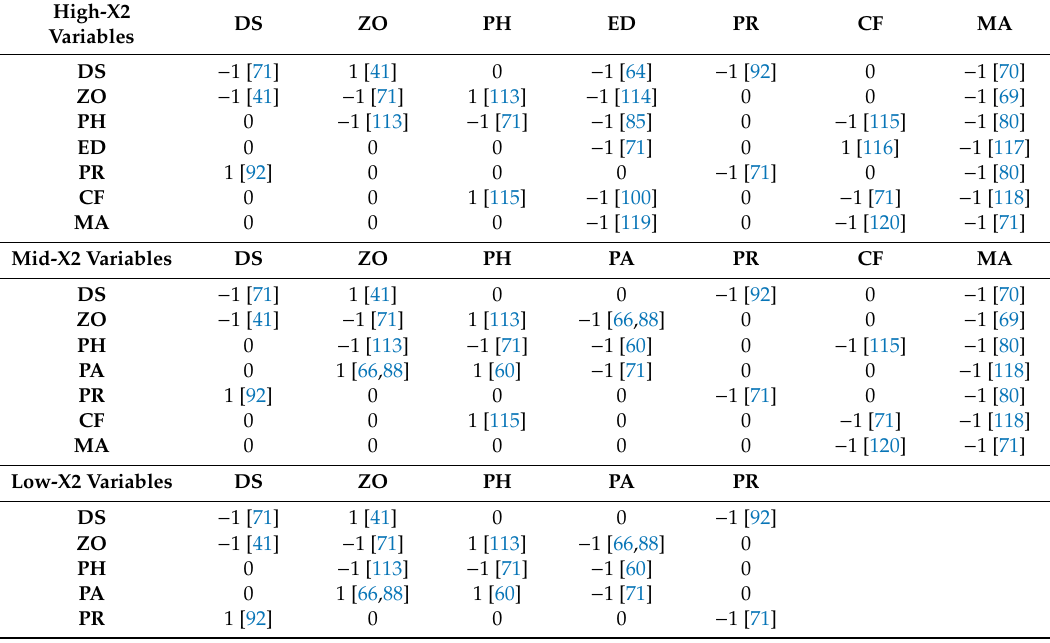
Table A1. Qualitative interactions for modeled community variables defined in Table 1 at the high-, mid-, and low-X2 positions in the upper San Francisco Estuary. (References shown in parentheses). High-X2